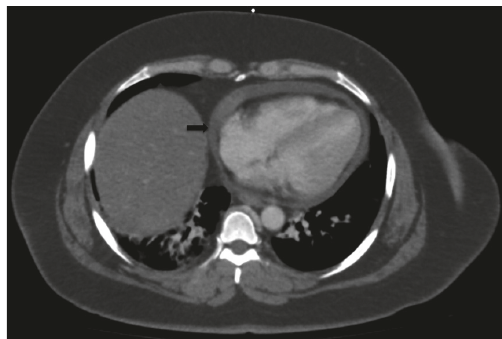
Figure 2: Computed tomography showing small pericardial effu- sion.